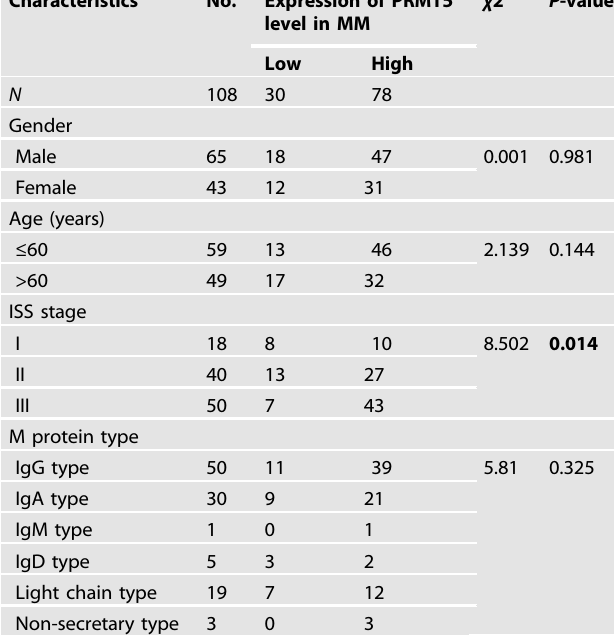
Table 1. The relationship between PRMT5 expression and clinicopathological characteristics in